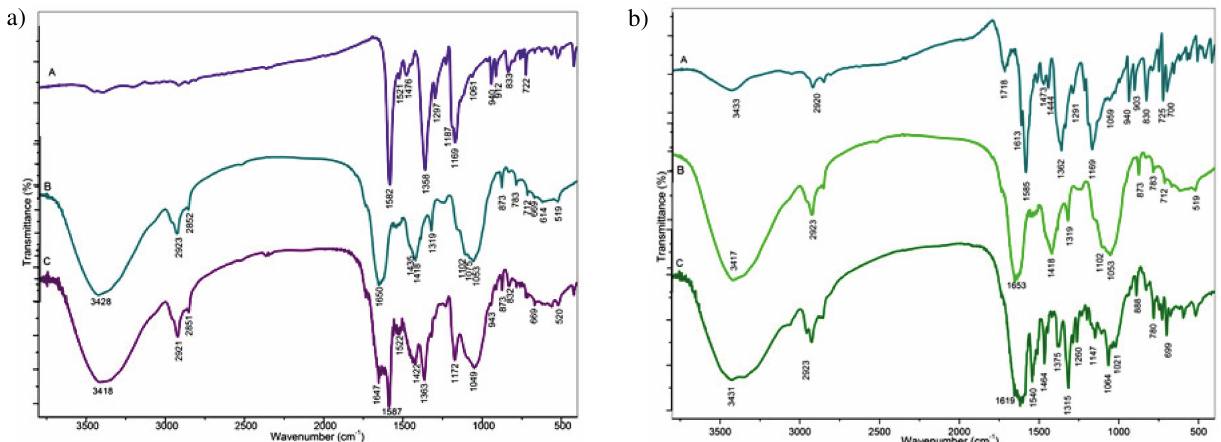
Fig. 5. a) FTIR spectra of the CV dye (A), Lemna minor control plant (B) and Lemna minor after the phytoremediation of CV; b) FTIR spectra of the MG dye (A), Lemna minor control plant (B) and Lemna minor after the phytoremediation of